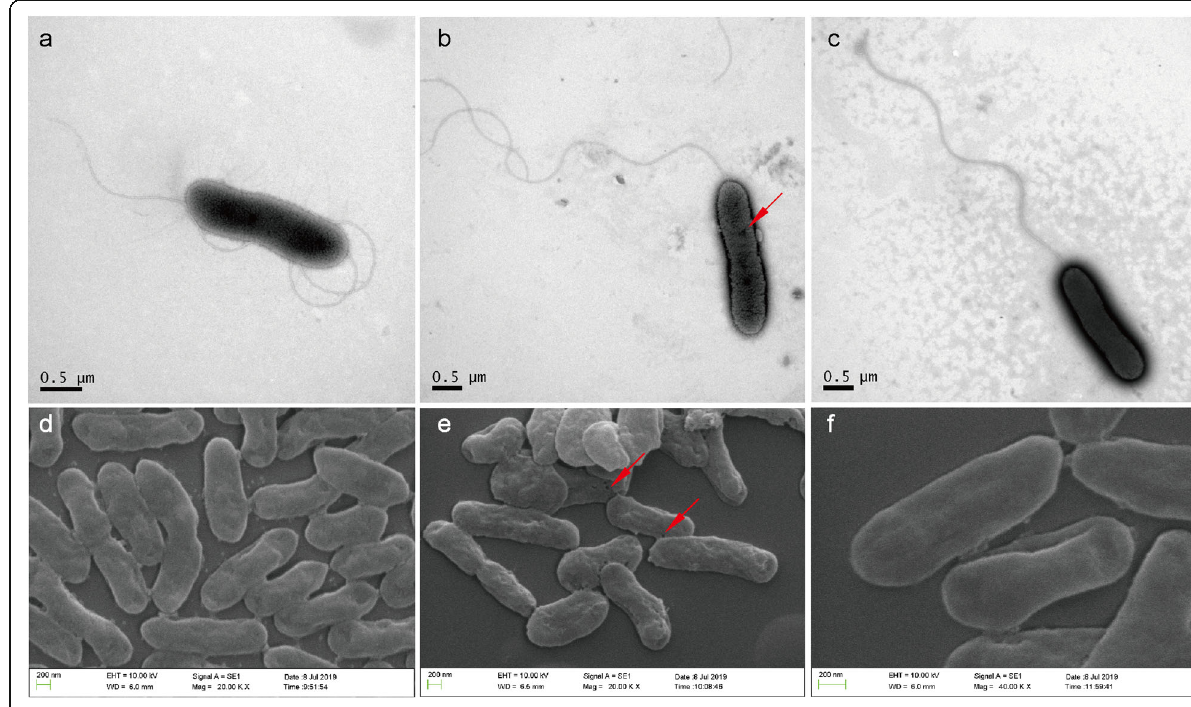
Fig. 5 Cell morphology of Xoo strain PXO99 observed with TEM ( a , b and c ) and SEM ( d , e and f ). a , d Non-treated PXO99 cells (0 μ g/mL zinc thiazole). b , e PXO99 cells treated with zinc thiazole (25 μ g/mL) in 0.125% DMSO. c, f PXO99 cells treated with 0.125% DMSO. Arrows indicate